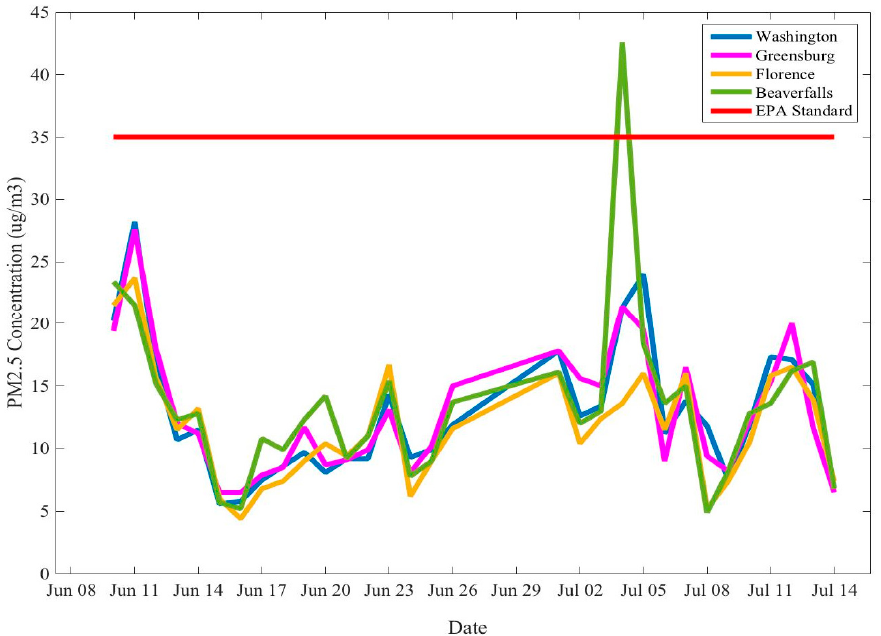
Figure 11. PM 2.5 measurements taken by the PA DEP monitoring sites during the study period. The red line represents the US EPA 24-hour NAAQS, the blue line represents the Washington monitoring site, the magenta represents the Greensburg monitoring site, the gold line represents the Florence monitoring site and the green line represents the Beaver Falls monitoring site. Atmosphere 2017 , 8 , 186